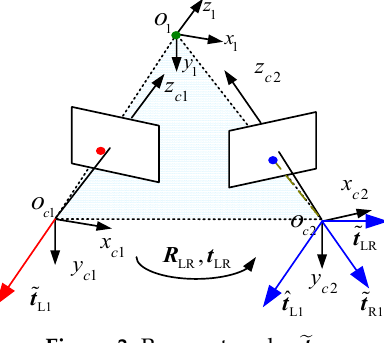
Figure 3. Process to solve